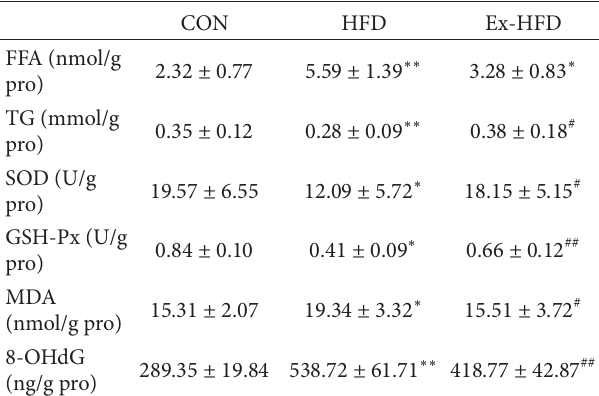
Table 1: Effect of swimming exercise on FFA, TG, and oxidative stress parameters in skeletal muscle.